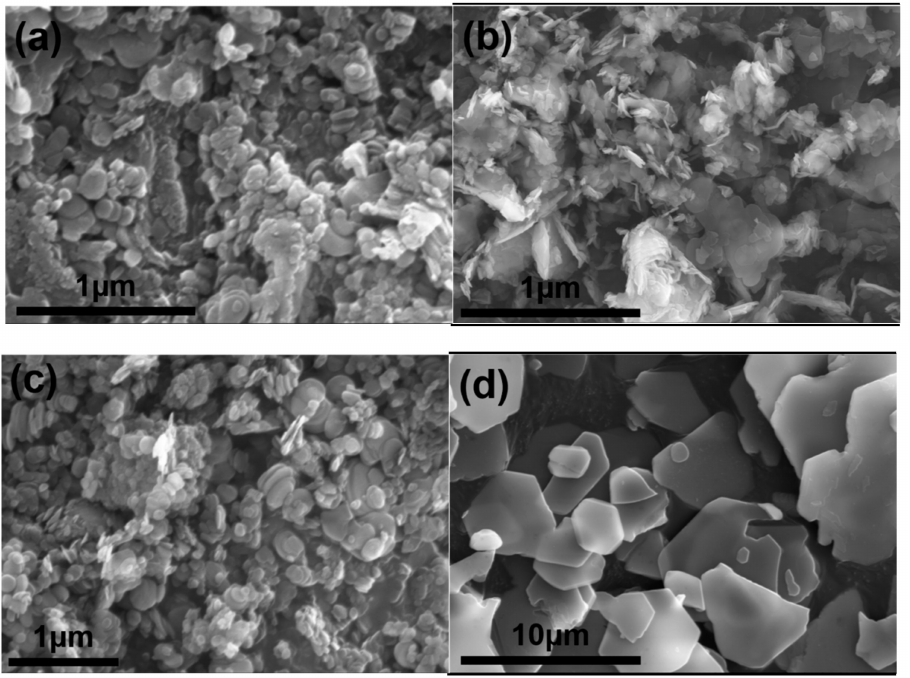
Figure 5. SEM images of ( a ) BNNSs; ( b ) BN m ; ( c ) BN n ; ( d ) Al 2 O 3